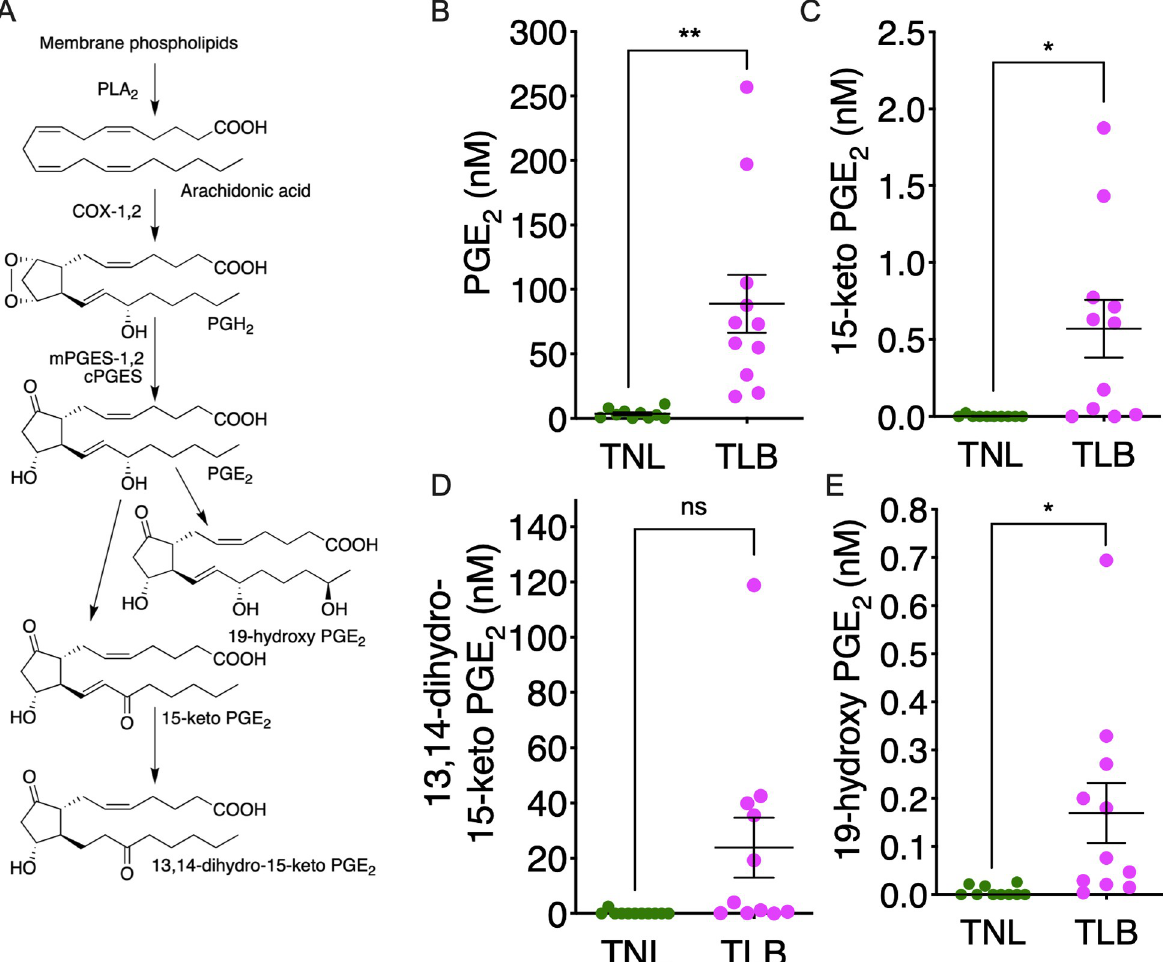
Fig 1. Levels of prostaglandin E 2 (PGE 2 ) and its metabolites in amniotic fluid. (A) PGE 2 biosynthesis and metabolism. Arachidonic acid released from membrane phospholipids by phospholipase A2 (PLA2) enzymes is acted on by either of the two cyclooxygenase (COX) isozymes, COX-1 or COX-2. The COX metabolite PGH 2 is then converted to PGE 2 by microsomal PGE synthase (mPGES-1), mPGES-2, or cytosolic PGE synthase (cPGES).